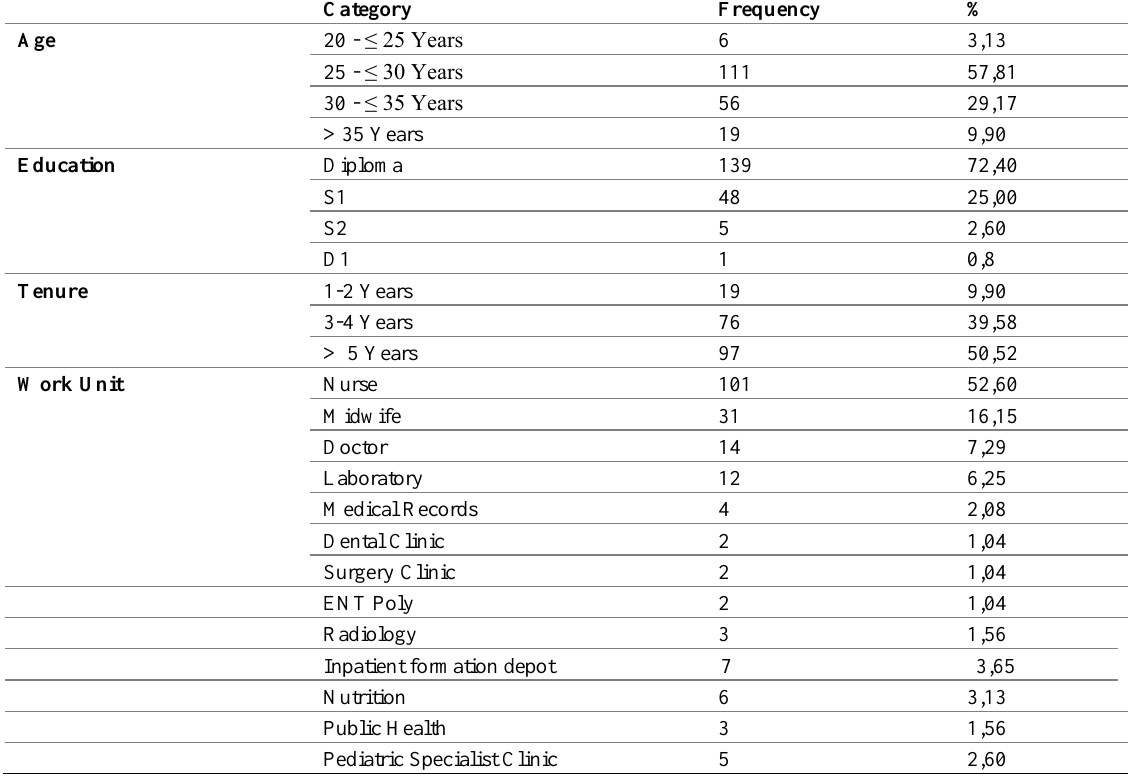
Table 1: Characteristics of